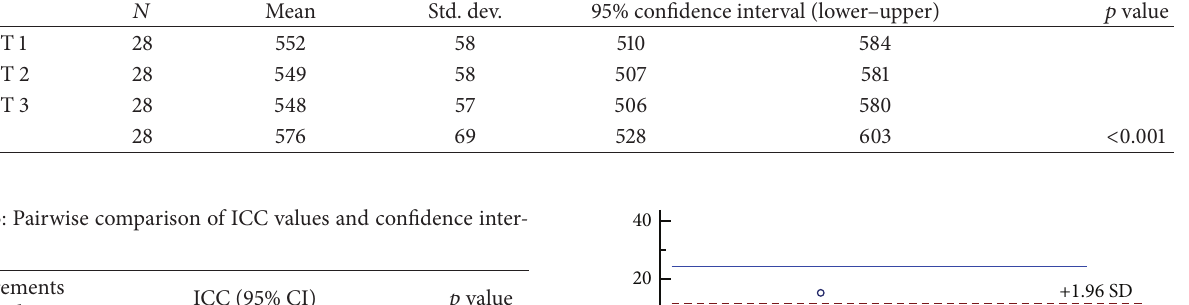
Table 2: Comparison of 3 measurements by SD-OCT in 28 premature infants and mean of 10 measurements by USP. 𝑁